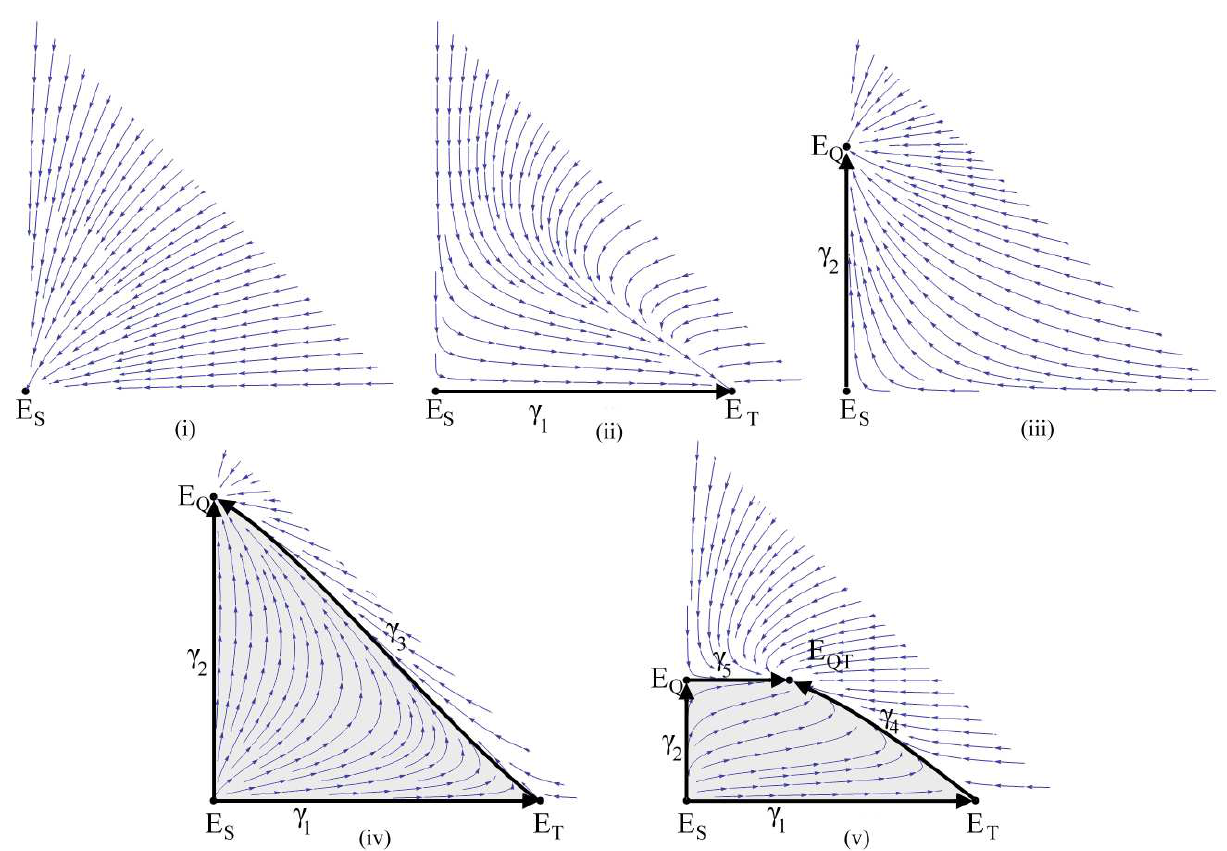
Fig. 1. Representation of the flow and the attractors on the TQ